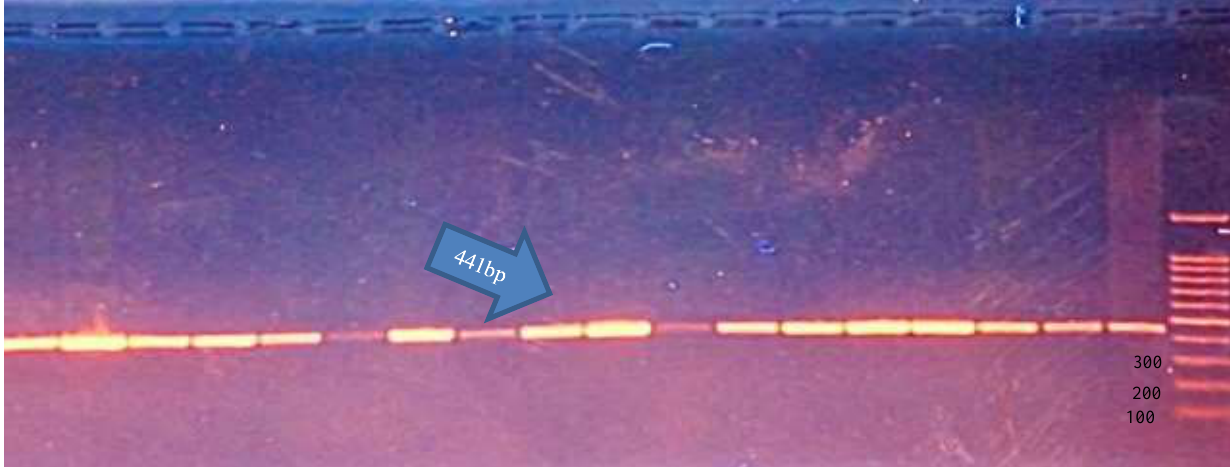
Figure 1: Detection of PCR product DNA bands of IL-17A gene using rs2275913 primers (441bp). The amplified fragments were separated by electrophoresis on a 1% agarose gel, stained with ethidium bromide at 70 volts for 60 minutes, and photographed under UV light. Lanes (1-10) patient with breast cancer gave band for an amplified fragment. M: Marker DNA ladder size (100bp to 1500bp).